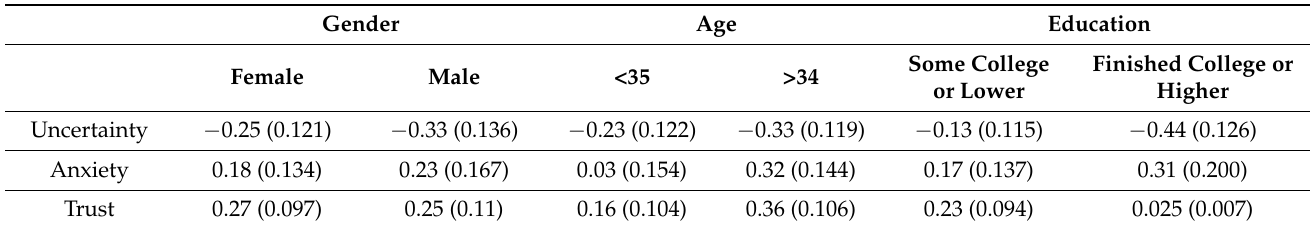
Table 5. Differences of the B values (with SDs) between subgroups of the sample, divided according to basic demographic